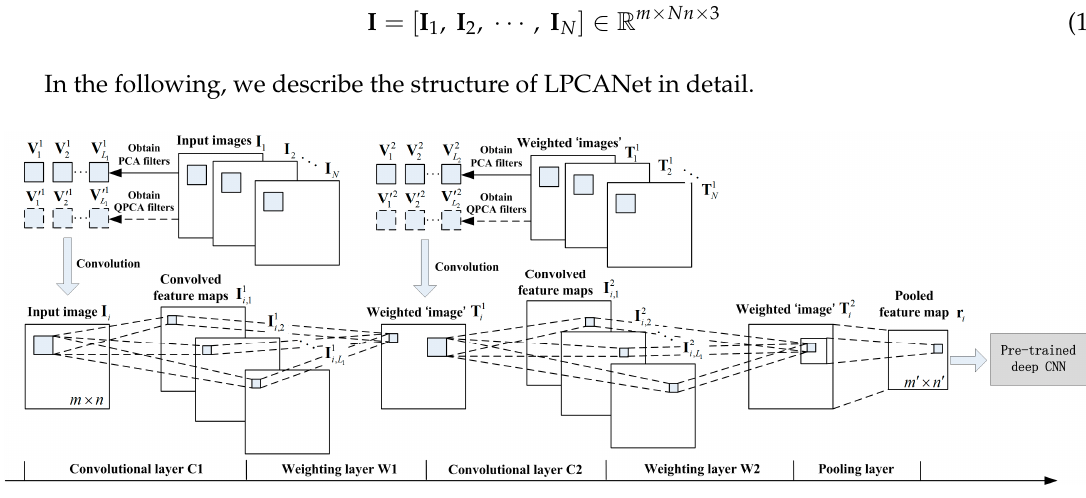
Figure 4. Structure of two-stage linear PCA network (linear quaternion PCA network).